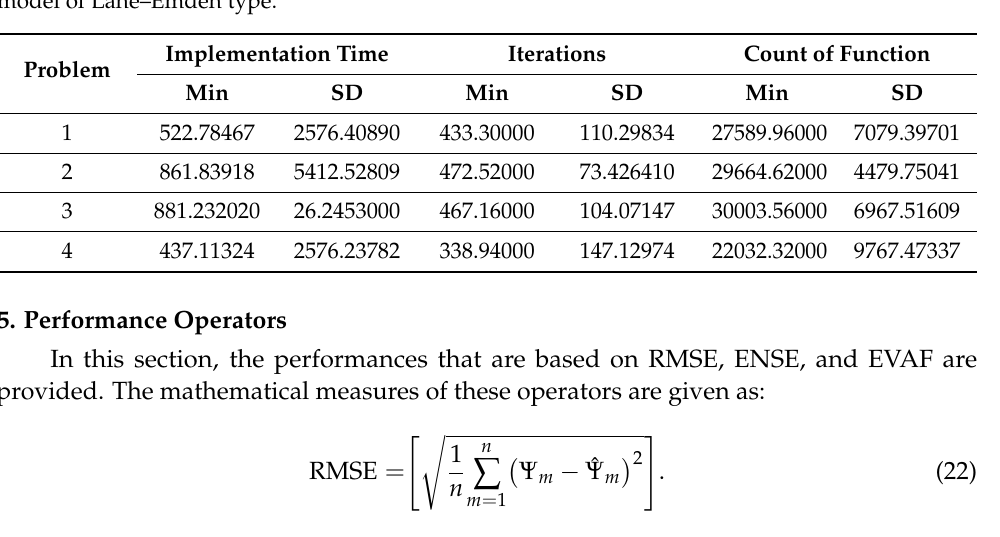
Table 6. The complexity performance through ANN-GA-SQPM for each example of the singular model of Lane–Emden